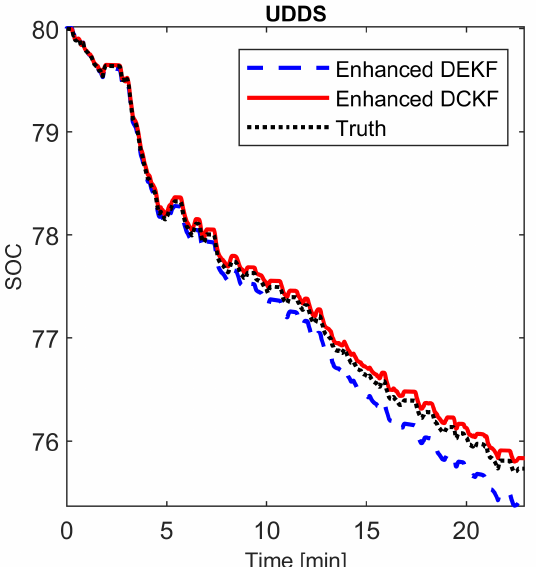
Figure 5. Performance evaluation of the dual Kalman filter variants in the UDDS